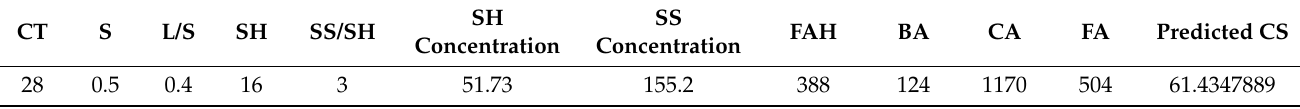
Table 6. Predicted GPC compressive strength for a new set of input